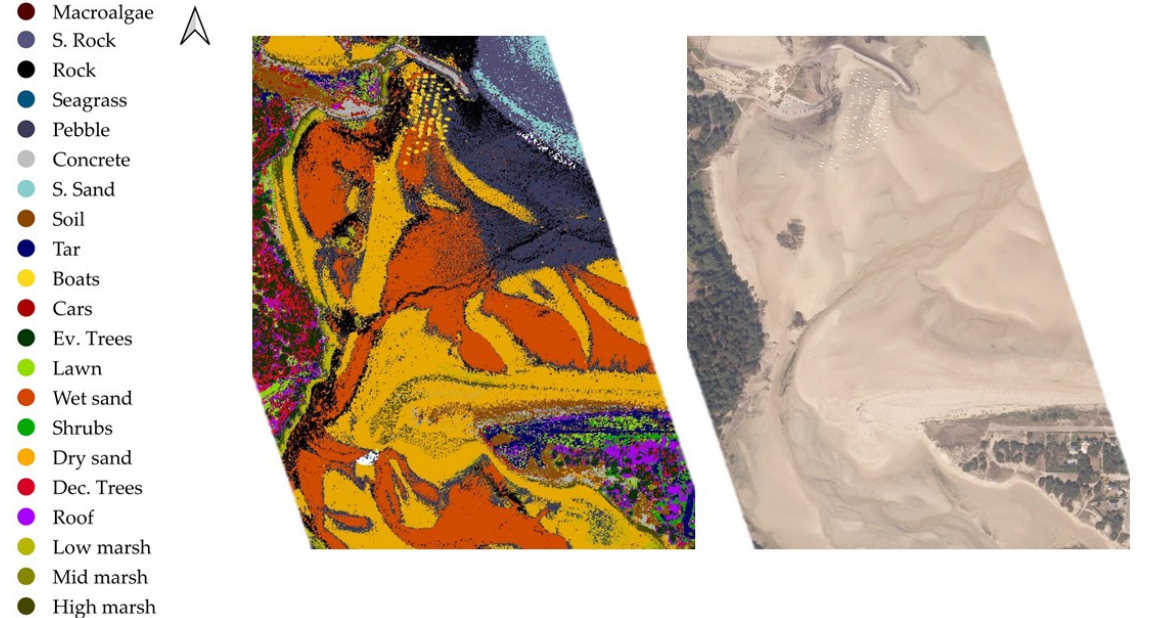
Figure 10. Urban area and sand beach classification: Extract of the projected 3D map of the habitats obtained with the predictions of a random forest classifier on green spectral features, infrared intensities, and elevation values, and extract of an orthoimage of the same area. The orthoimage was captured in 2014, while lidar data are not contemporaneous as they date from 2019. S. = submerged, Ev. = evergreen, Dec. = deciduous.